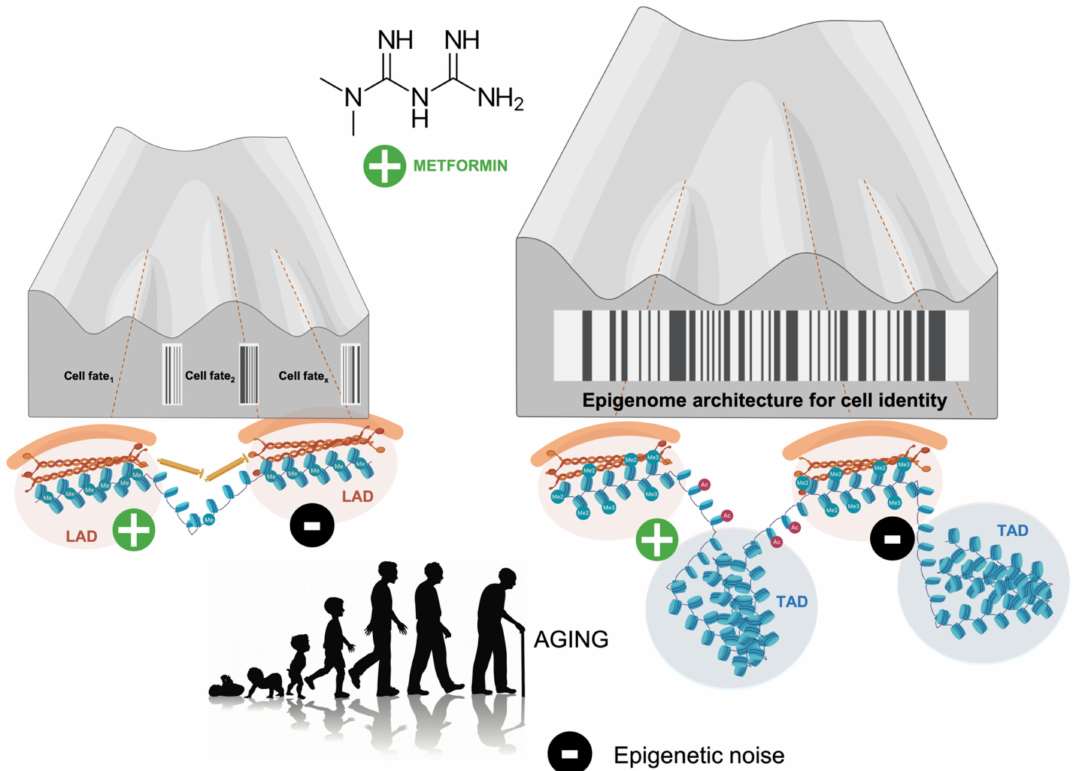
Figure 3. Metformin-regulated noise in the aging epigenetic landscape. Beyond the deterministic model depicted in Figure 2, one should acknowledge that transition states and cell fate decision at branching points of Waddington’s landscape can take place in a discontinuous stochastic manner in which aging noise modulate the probability of transition events. Crucially, the changing deepness and tallness of the valleys and hills can be governed, at least in part, by changes in the three-dimensional (3D) topology of the (epi)genome including lamina-associated domains (LADs) at the nuclear periphery and promoter–enhancer contacts regulating gene expression within topologically-associated domains (TADs) in the nucleus; such structures, which are continually responding to intra- and extracellular cues during development, di ff erentiation, and tissue homeostasis, a ff ects the contour of the epigenetic landscape itself to modulate the e ff ects of noise [16–19]. Although unproven, the ability of metformin to regulate the 3D shaping of chromatin topology via maintenance of TADs and LADs would favor a physiological / reparative resolution in response to decreased signal-to-noise ratios in cells / tissues undergoing a smoothing of the epigenetic landscape. Perhaps more importantly, the targeting of the cross-talk between (epi)genomic organizers with metformin might provide key mechanistic insights into 4-dimensional (4D) regulatory changes in (epi)genome architecture, where the 4th dimension is aging